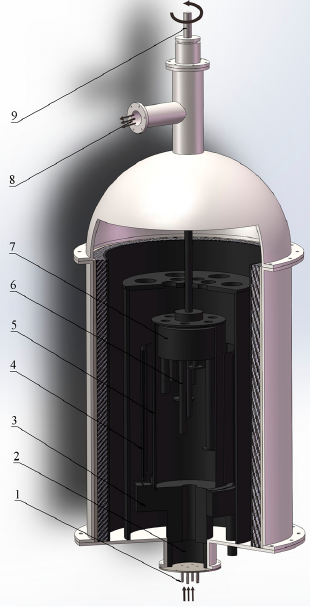
Figure 1. 3D model diagram of the CVD (chemical vapor deposition) reactor. ( 1 ) Air inlet; ( 2 ) gas mixing chamber; ( 3 ) electrode; ( 4 ) heating resistor; ( 5 ) deposition chamber; ( 6 ) high purity graphite substrate; ( 7 ) sample stage; ( 8 ) air outlet; ( 9 ) rotating shaft.